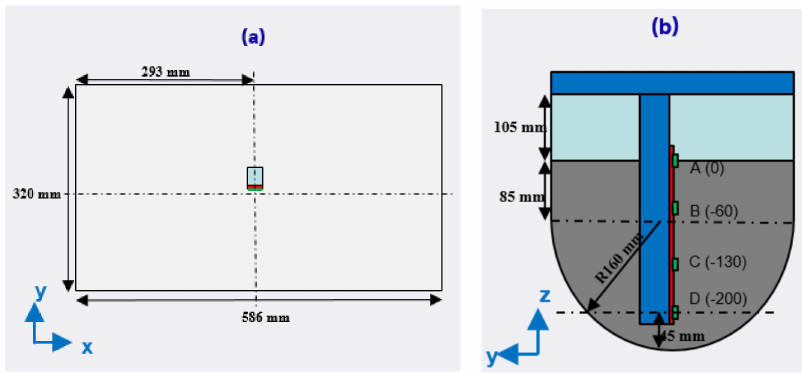
Figure 3. Setup configuration in ( a ) top view and ( b ) side